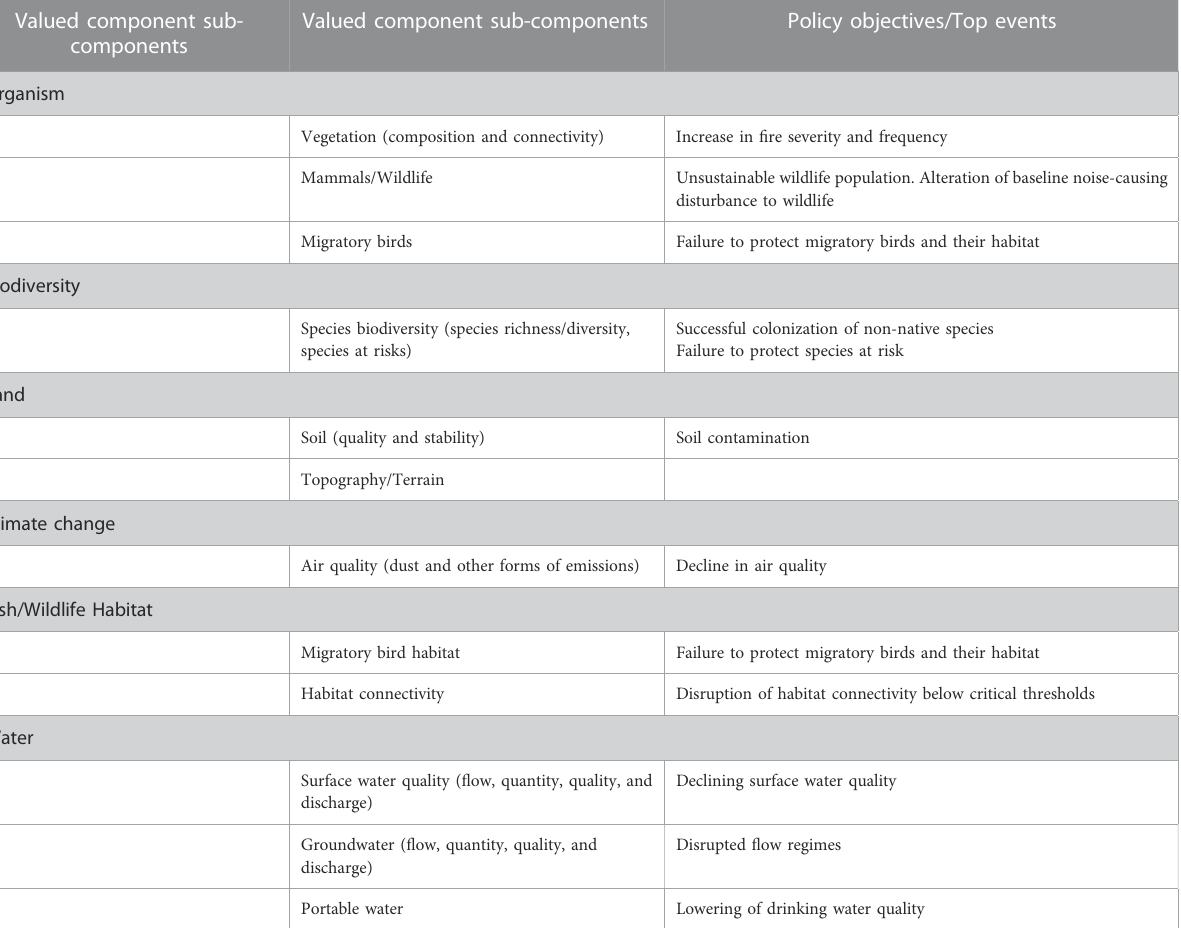
TABLE 2 VECs and sub-VECs and relationship to speci fi c policy